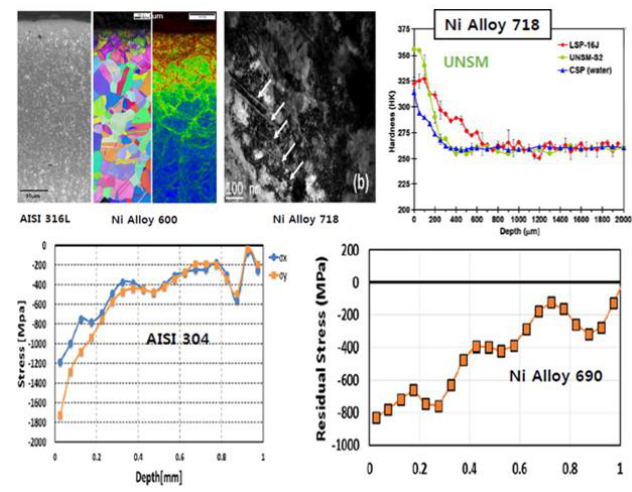
Figure 7. Examples of changes in mechanical properties and microstructure of nuclear materials.